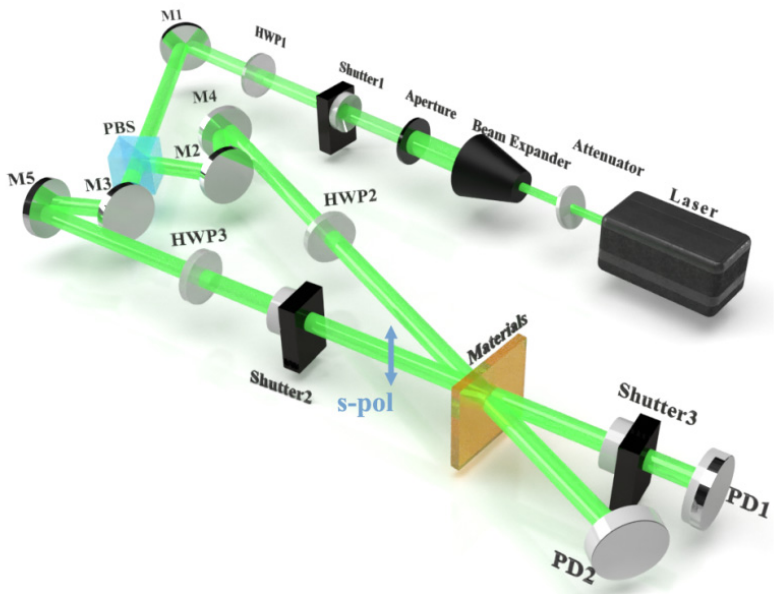
Figure 14. Experimental setup for diffraction efficiency measurement. HWP: half-wave plate; PBS: polarization beam splitter; PD: photodetector; M: mirror.